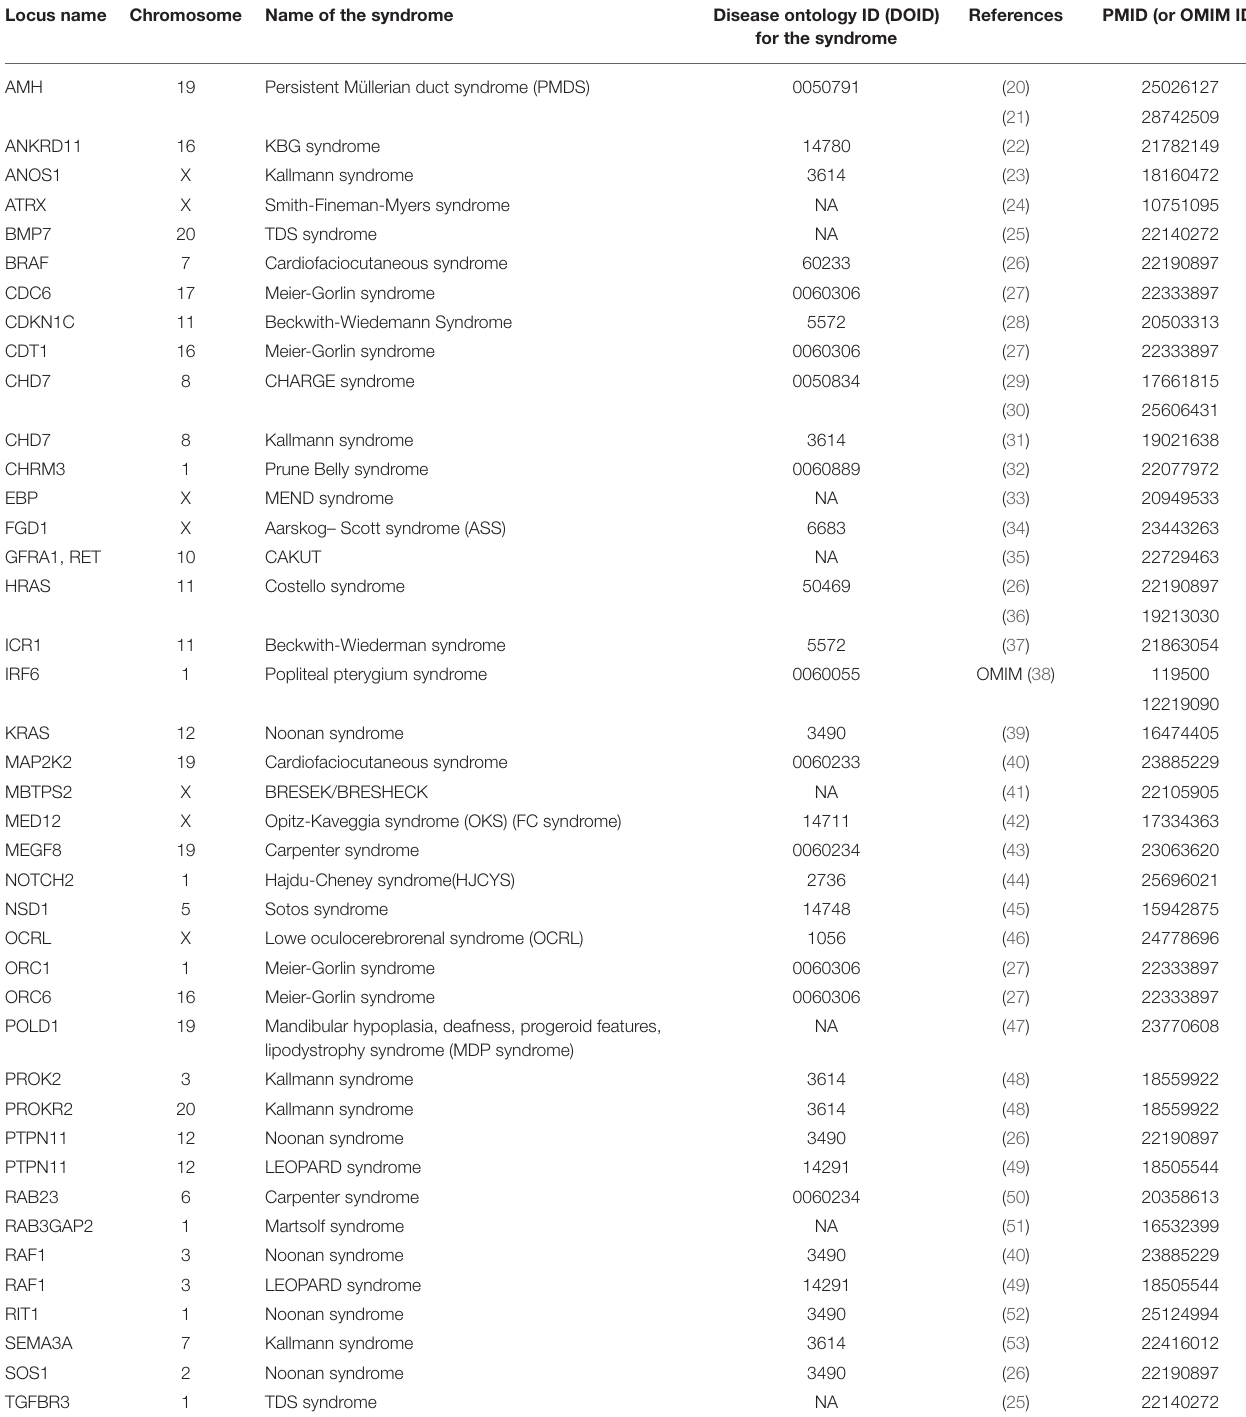
TABLE 1 | Protein-coding genes, associated with syndromes with cryptorchidism in clinical picture. Locus name Chromosome Name of the syndrome Disease ontology ID (DOID)